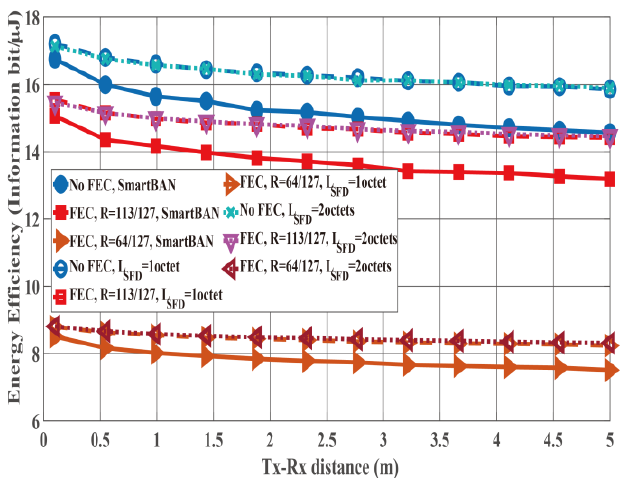
Figure 17. Energy efficiency performance as a function of the Tx-Rx distance. Cases without and with SFDs ( 𝐿 𝑆𝐹𝐷 = 1 octet and 2 octets).